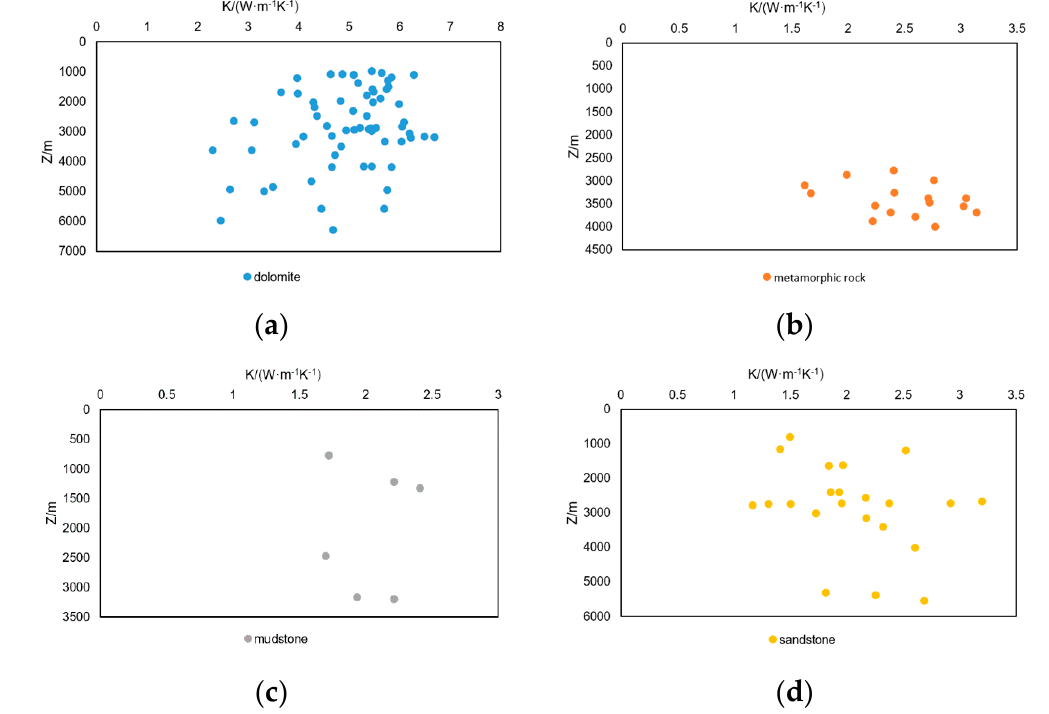
Figure 11. Relationship between thermal conductivity and depth of main lithologies. Relationship between dolomite and depth ( a ); Relationship between metamorphic rock and depth ( b ); Relationship between mudstone and depth ( c ); Relationship between sandstone and depth ( d ).